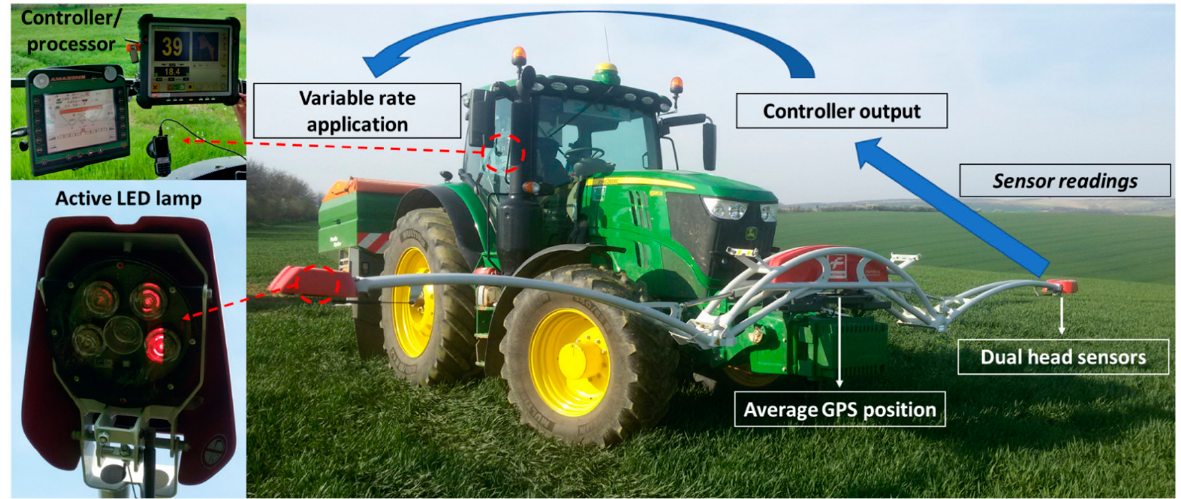
Figure 3. Nitrogen application by the Fritzmeier ISARIA crop sensing system in the field. Photo by J. Mezera (2019).